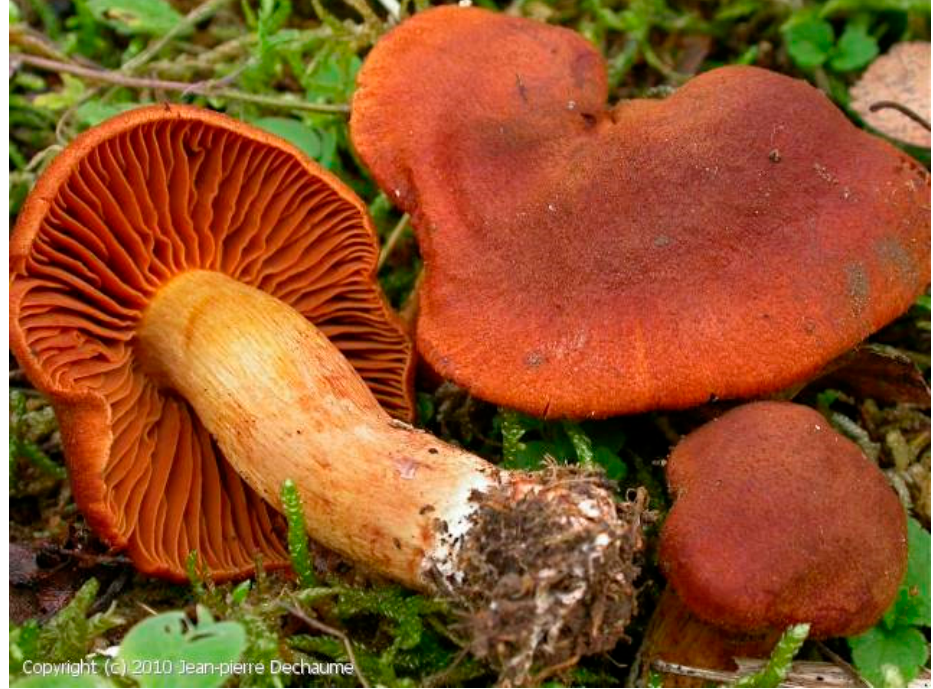
Figure 2. Cortinarius orellanus [30].